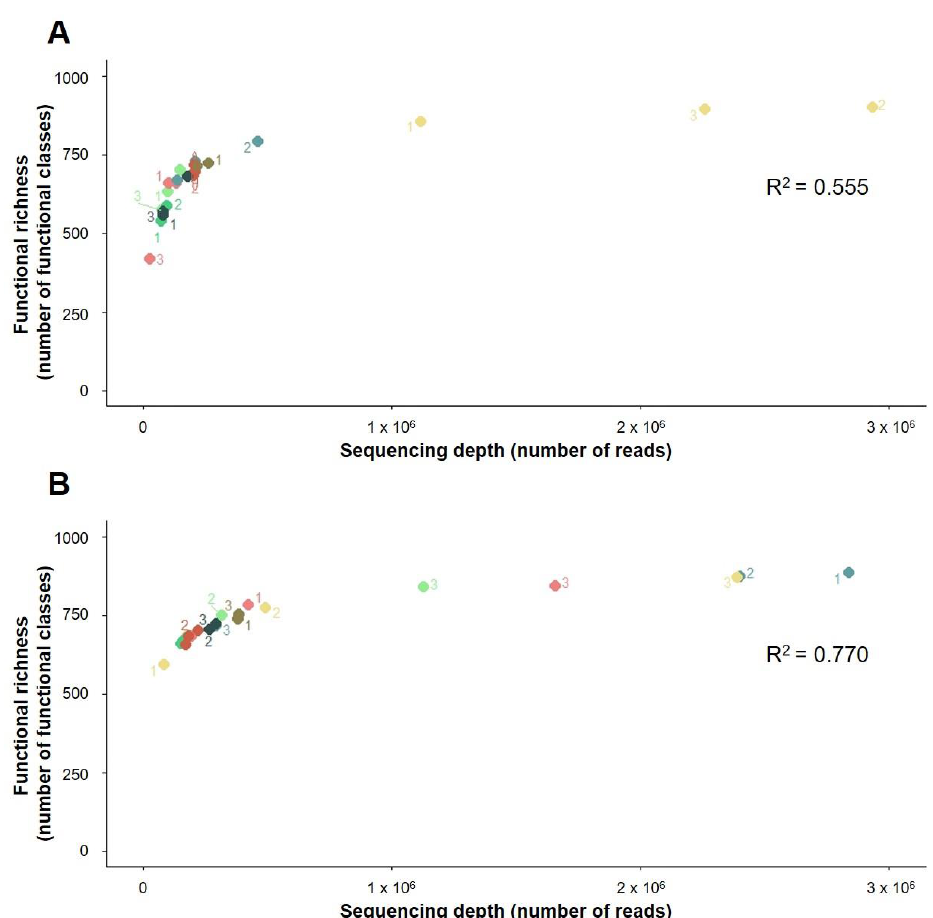
Figure 2. Effect of sequencing depth on the functional richness discovery from ( A ) the Scottish Agricultural College soil (Craibstone, Scotland) and ( B ) La Côte de Saint André soil (France). Green: Maxwell 1 modification of the prototype Maxwell RSC Fecal Microbiome DNA Kit (Promega). Red: Maxwell 2 modification of the prototype Maxwell RSC Fecal Microbiome DNA Kit (Promega). Blue: Phenol/Chloroform. Yellow: DNeasy PowerSoil Kit (QIAGEN). The functional richness (second SEED sublevel of classification) measured in each sample was determined and plotted as a function of the sequencing depth. For each method/soil pair, triplicates (labelled 1, 2, and 3) were sequenced twice and plotted in the graph. Lighter colours represent the first sequencing run, and darker colours represent the second sequencing run. Correlation p- value: 4.55 × 10 −5 (Scottish Agricultural College soil) and 1.72 × 10 −7 (La Côte de Saint André soil).